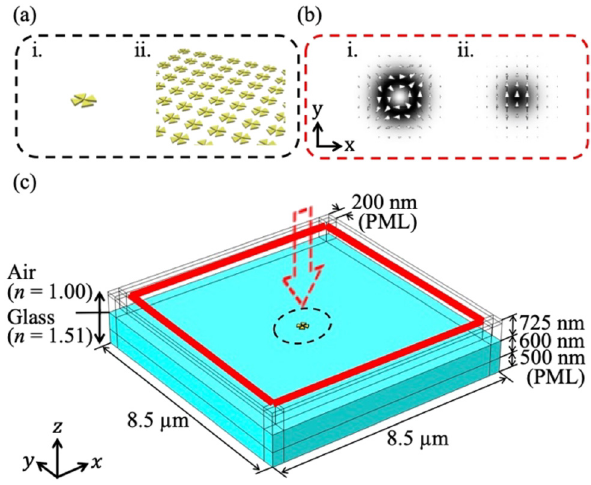
Figure 7: Numerical simulation model. (a) Two types of nanosystems: (i) an isolated gold tetramer and (ii) a gold tetramer array. (b) Schematic of two types of incident beams: (i)aCVbeamwithaquadrupolepro fi leand(ii)aGaussianbeamwith linearpolarization.Thearrowsindicateelectric fi eldvectors,andthe gray shading indicates the electric fi eld intensity. (c) Geometry of our calculation model considering the gold tetramer structures on the glass substrate in air. The incident beam propagates in the z -direction from the top surface (bounded by the solid red